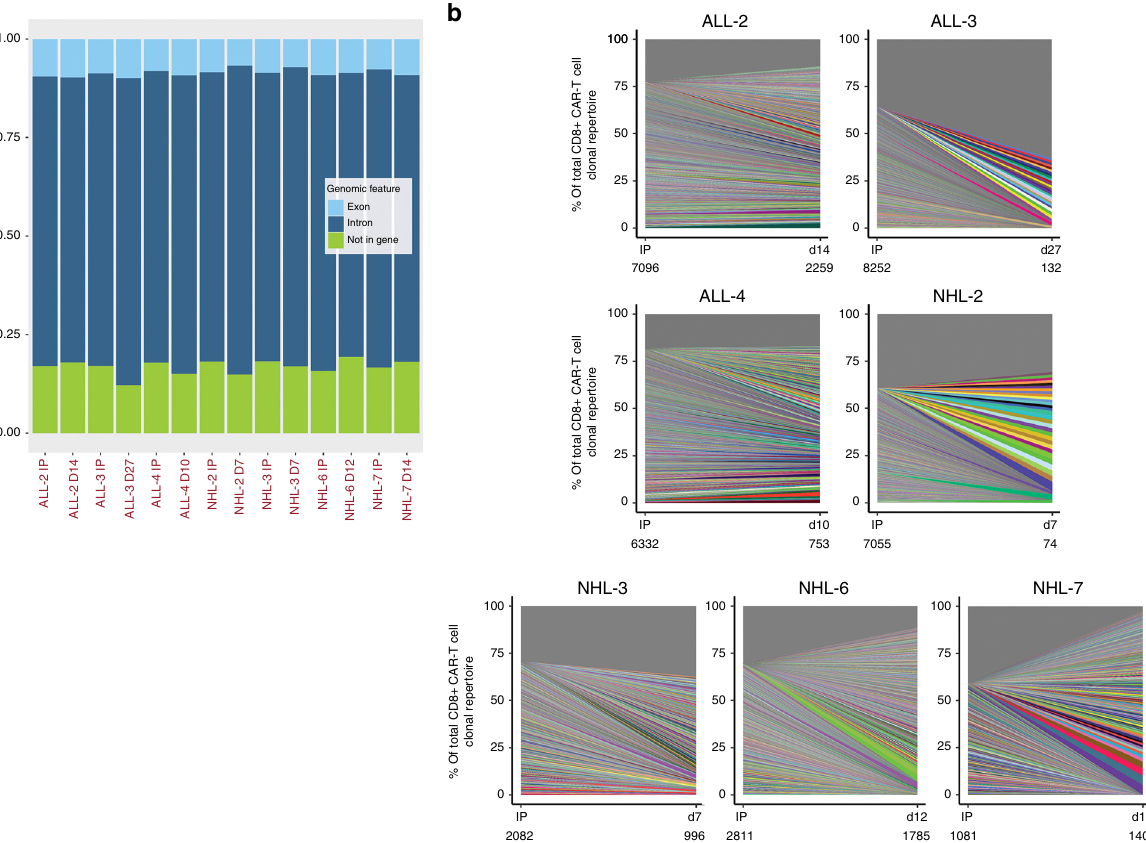
Fig. 4 Integration site analysis suggests multiple clones contribute to CAR-T cell pools. a Bar chart depicts the percentage of integration sites found within an exon, intron, or not in a gene for CD8 + CAR-T cells. b Graphs represent the contribution (% frequency) of all identi fi ed clones by integration site analysis in IP and blood samples collected after infusion ( x axis). Each color ribbon represents a unique clone demonstrating ≥ 1% frequency of sequence reads in a given sample. All other clones are grouped into the gray ribbon at the top of each graph. The total number of unique clones identi fi ed in the sample is listed underneath the sample ID for each graph (below the x